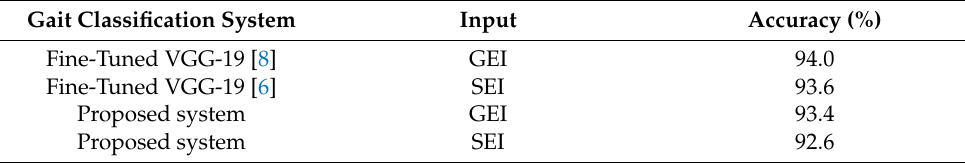
Table 1. Cross-validation results obtained using the GAIT-IT dataset.